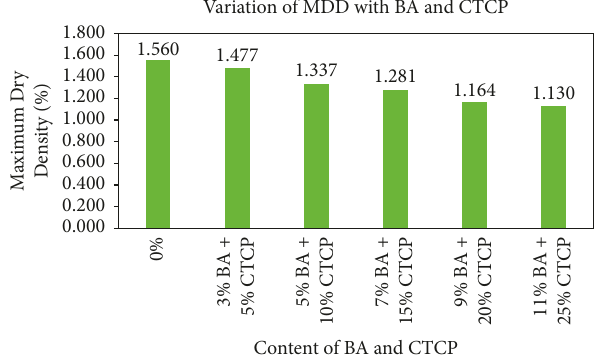
Figure 14: Combined effect of BA and CTCP on